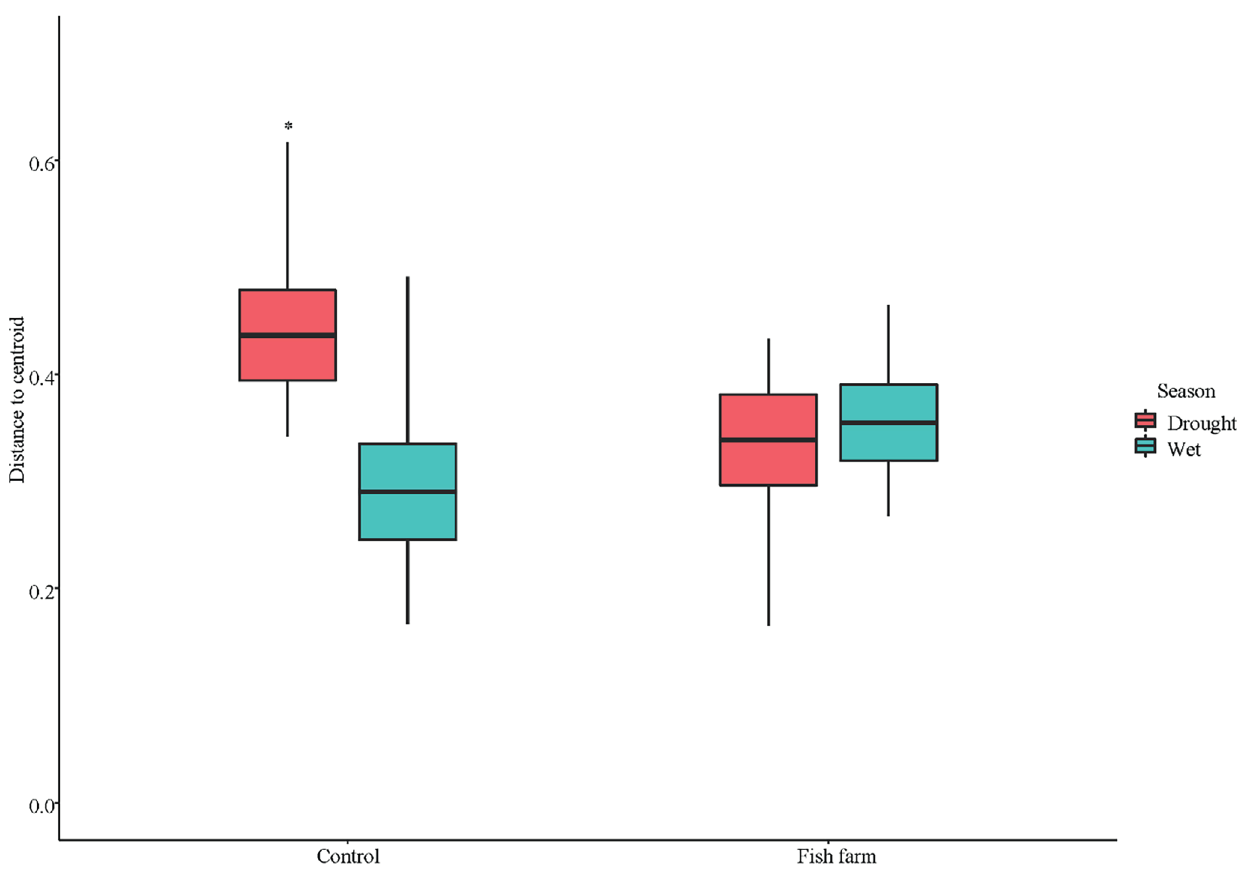
FIGURE 4 | Beta diversity (PERMDISP) in the drought and wet seasons in the control and fish farm areas at the Ilha Solteira reservoir, Upper Paraná River, São Paulo, Brazil. Average distances of centroids with presence/absence of data. Asterisks indicates significant upper value between seasons within each